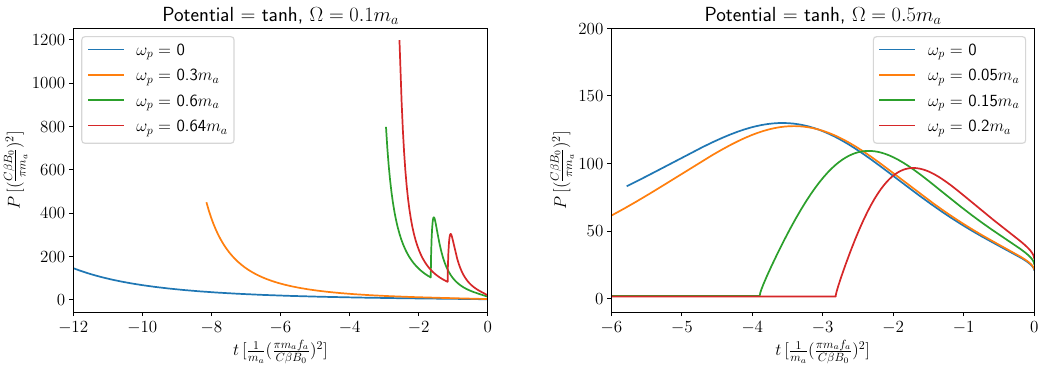
Figure 8 . Power radiated as a function of time for the tanh-potential for a few different values of the external magnetic field frequency Ω and the plasma frequency ω p . Again, we have ω ( t = 0) = ω crit .